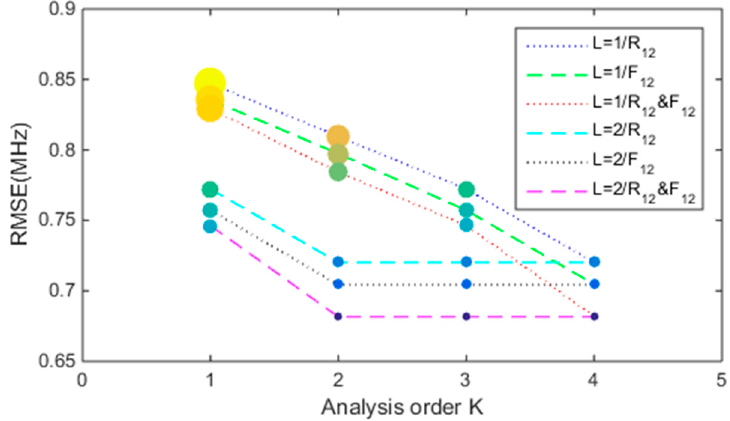
Figure 6. Bubble chart of Root-mean-square error of different analysis order. The size of bubble is set by 10 7(REMS − 0.5) for better comparison viewing.